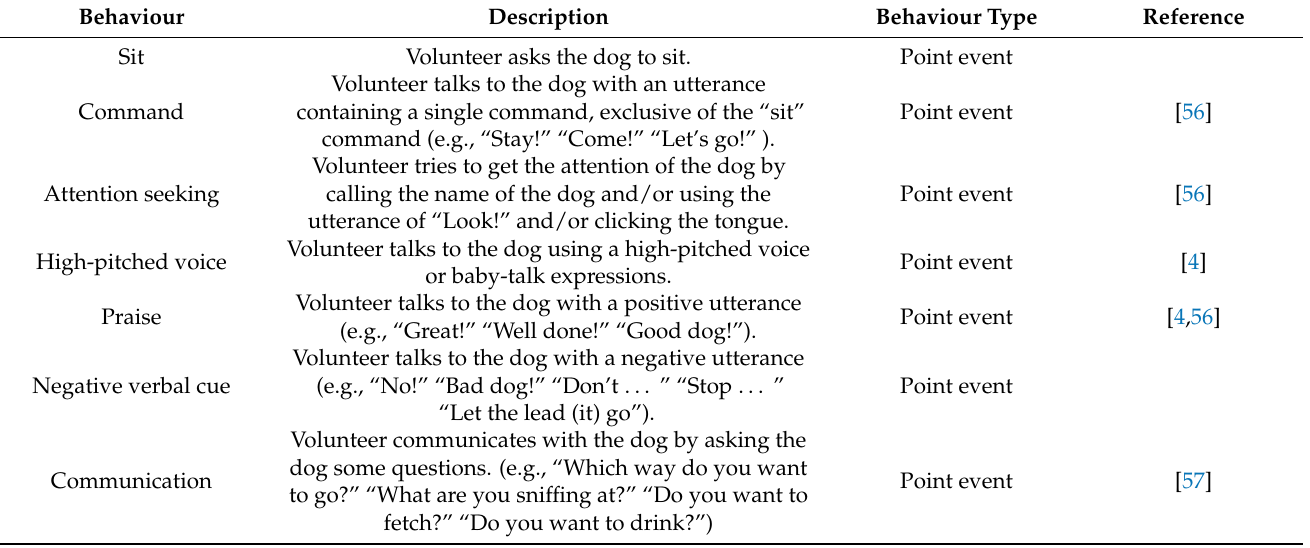
Table 3. Ethogram of human verbal cues [49].